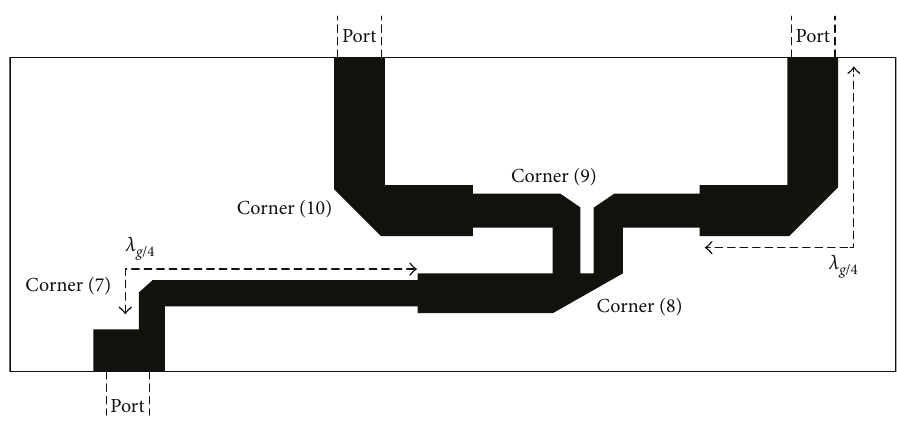
Figure 5: Power divider with mitred bend. Table 1: Parameter corners of the proposed array antennas.